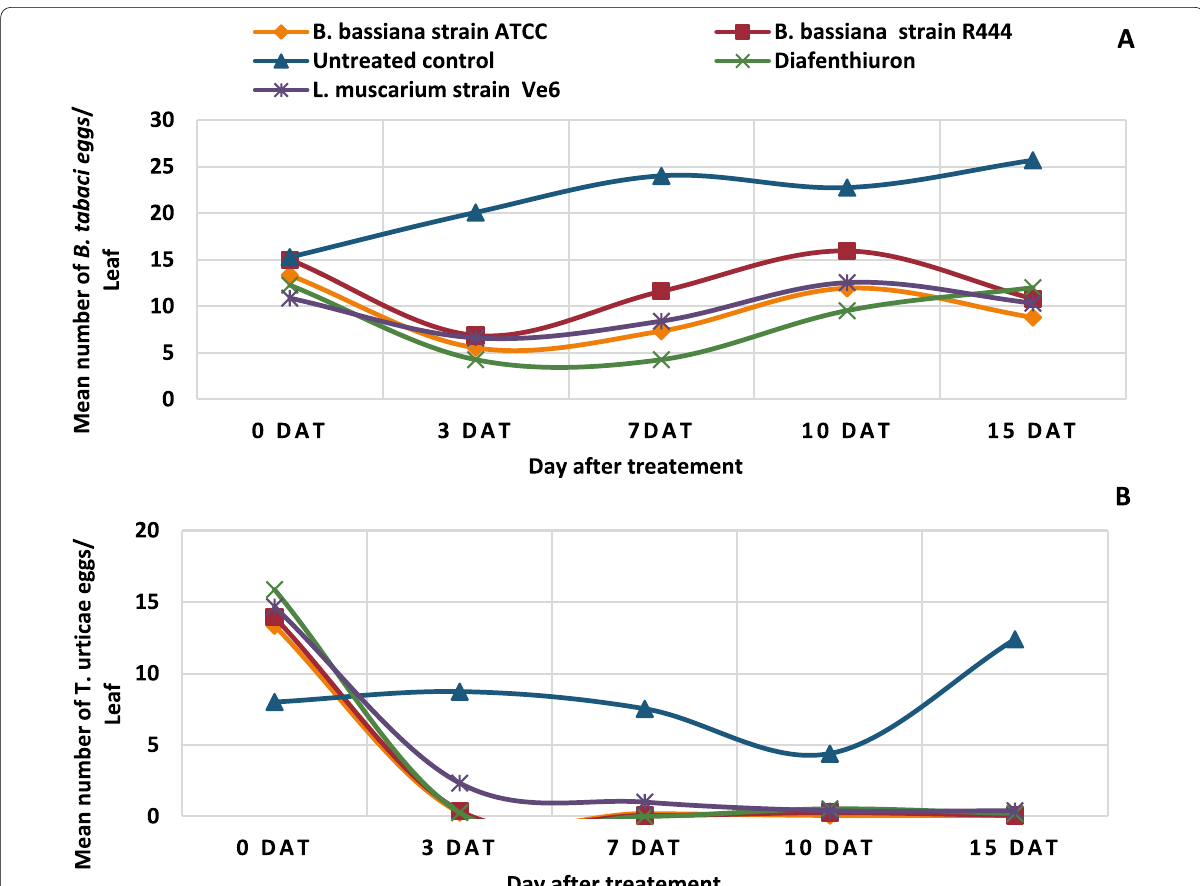
Fig. 2 Mean number of Bemisia tabaci eggs and Tetranychus urticae as a function of treatment with entomopathogenic fungi for 15 days ( A : Bemisia tabaci eggs, B : Tetranychus urticae eggs)